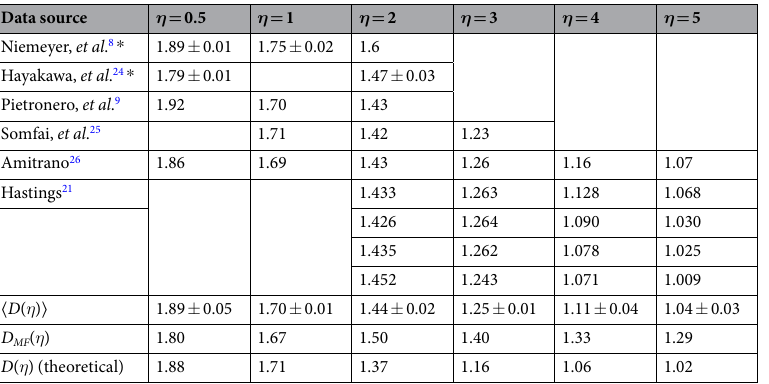
Table 1. Fractal dimensions of the DBM. The first section of the table summarizes the fractal dimensions reported for the two-dimensional version of the model. The second section of the table is filled with the average fractal dimension 〈 D ( η ) 〉 , obtained as the arithmetic mean over each column with its corresponding standard deviation, the mean-field theory and the analytical result obtained here (last row). Data sources marked with an asterisk are not considered in the average due to limitations in their simulations. The error in the reported measurements is shown if